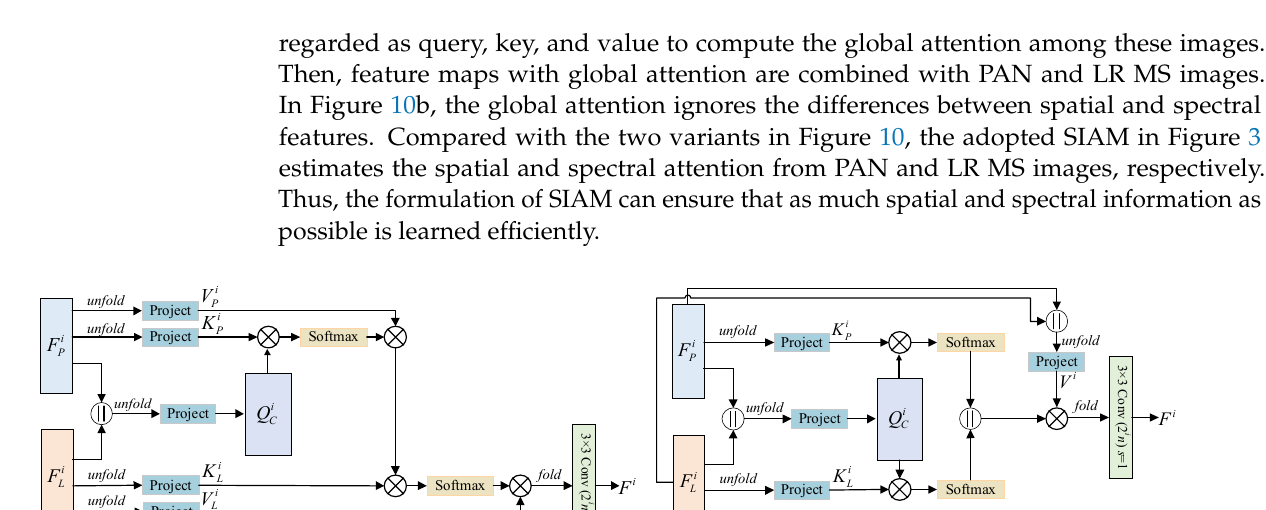
Figure 11 shows the fusion results of the proposed framework with different atten-